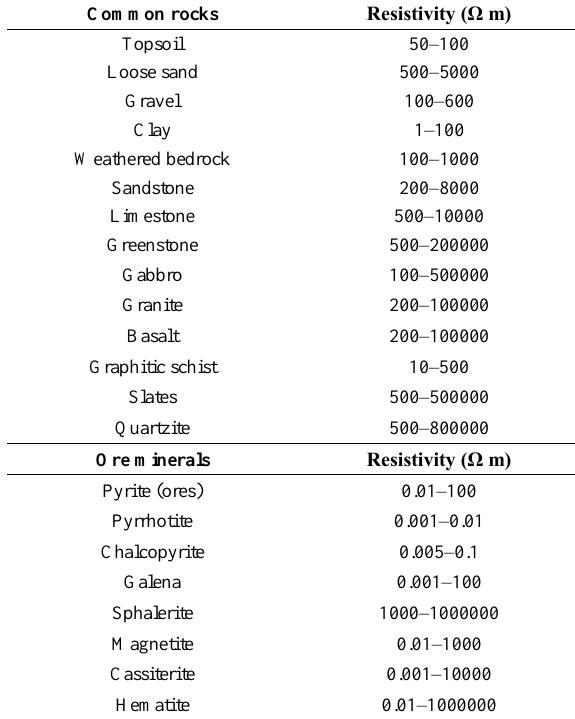
Table 1. Electrical resistivity values for common rocks and ore minerals; Adapted from Octova and Yulhendra